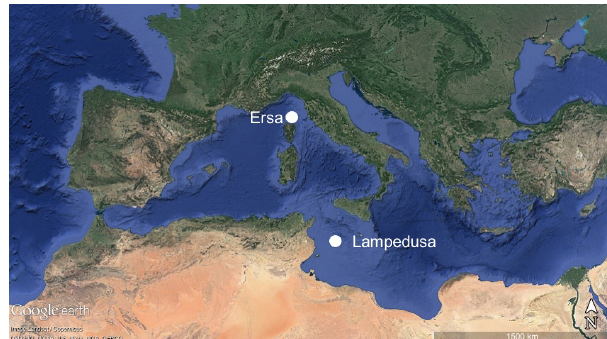
Figure 1. The Mediterranean basin. The two sites considered in this study, Lampedusa and Ersa, are indicated in white dots. Image is courtesy of © Google Earth